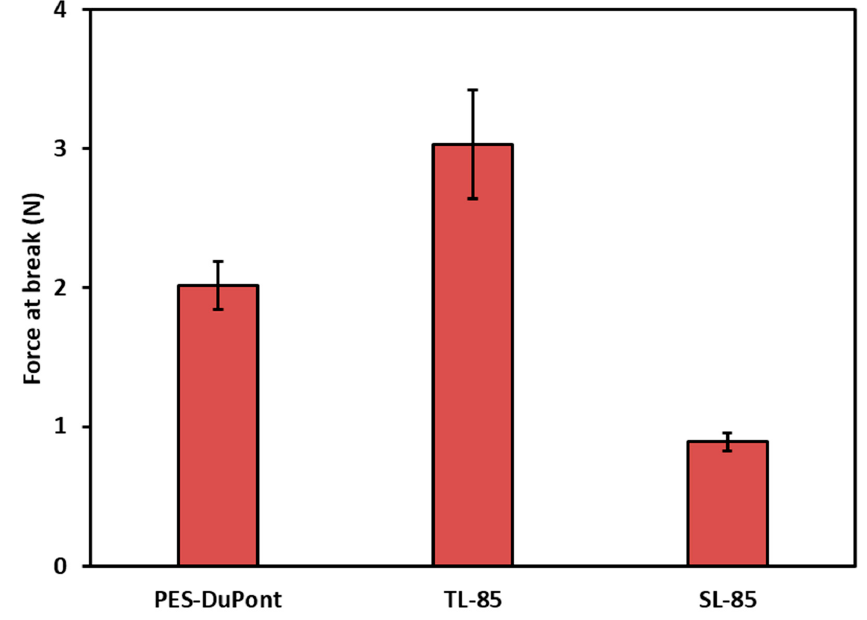
Figure 5. The force at break of the triple layer membrane, PES and the single layer PVDF membrane.